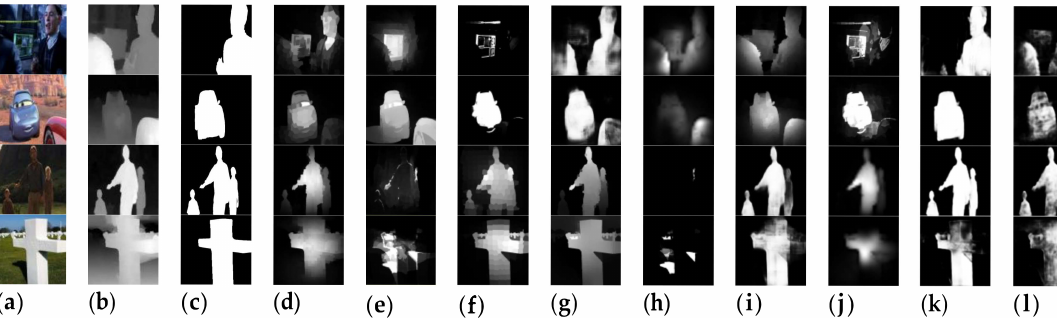
Figure 3. Examples of salient object detection from the testing set. ( a ) Original image, ( b ) depth map, and ( c ) ground truth. Saliency maps obtained from ( d ) ACSD, ( e ) CDCP, ( f ) DCMC, ( g ) DF, ( h ) MBP, ( i ) PDnet, ( j ) SFP, ( k ) proposed HANet, and ( l ) HANet without RGB attention map (ablation study). The RGB-D imges are selected form Ref. [33].